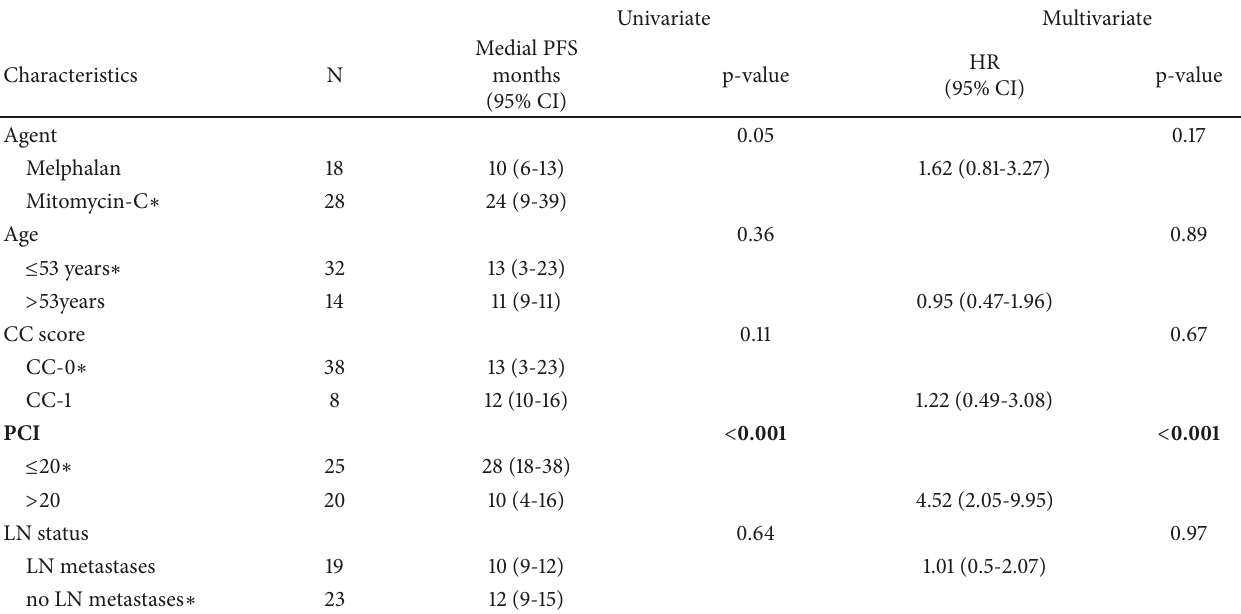
Table 3: Univariate and multivariate analysis of progression free survival in patients with colorectal cancer, treated with melphalan or mitomycin-C as a HIPEC